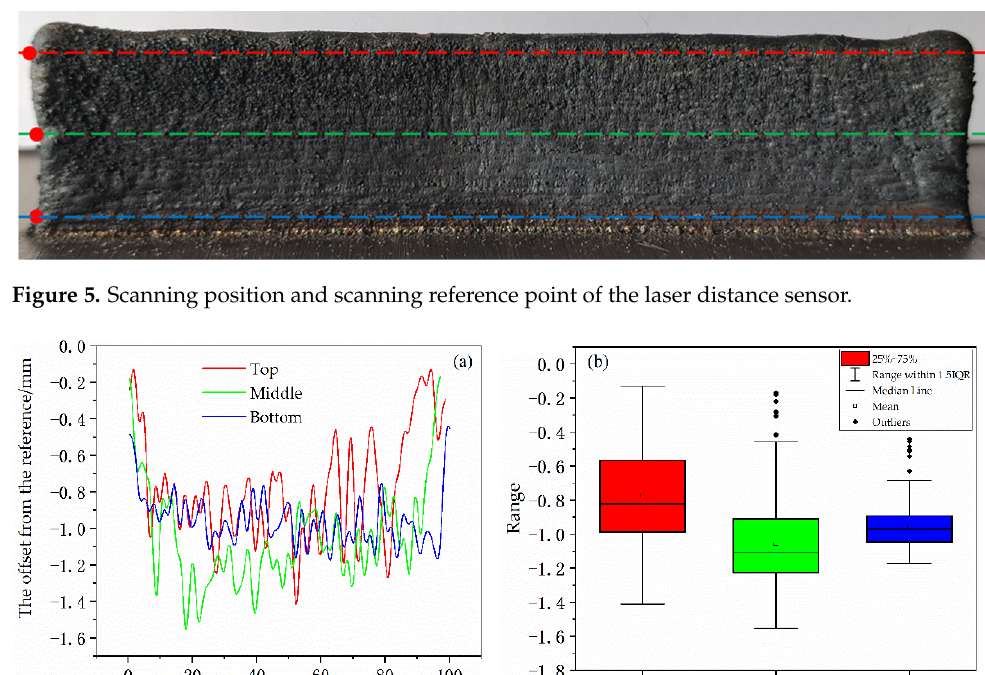
Figure 5. Scanning position and scanning reference point of the laser distance sensor.